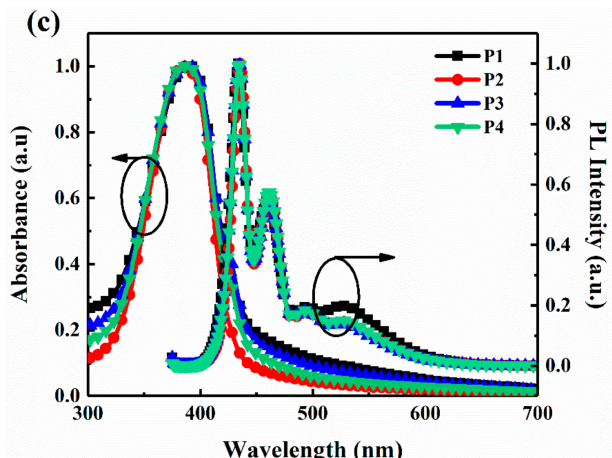
Figure 6. The ultraviolet–visible (UV–vis) absorption spectra and the normalized PL spectra, ( a ) the UV–vis absorption spectra of Ir(piq) 3 and fluorenone (FO) and the PL spectra of PFO and FO in THF solutions (5 × 10 − 6 M), and ( b ) the UV–vis absorption spectra and the normalized PL